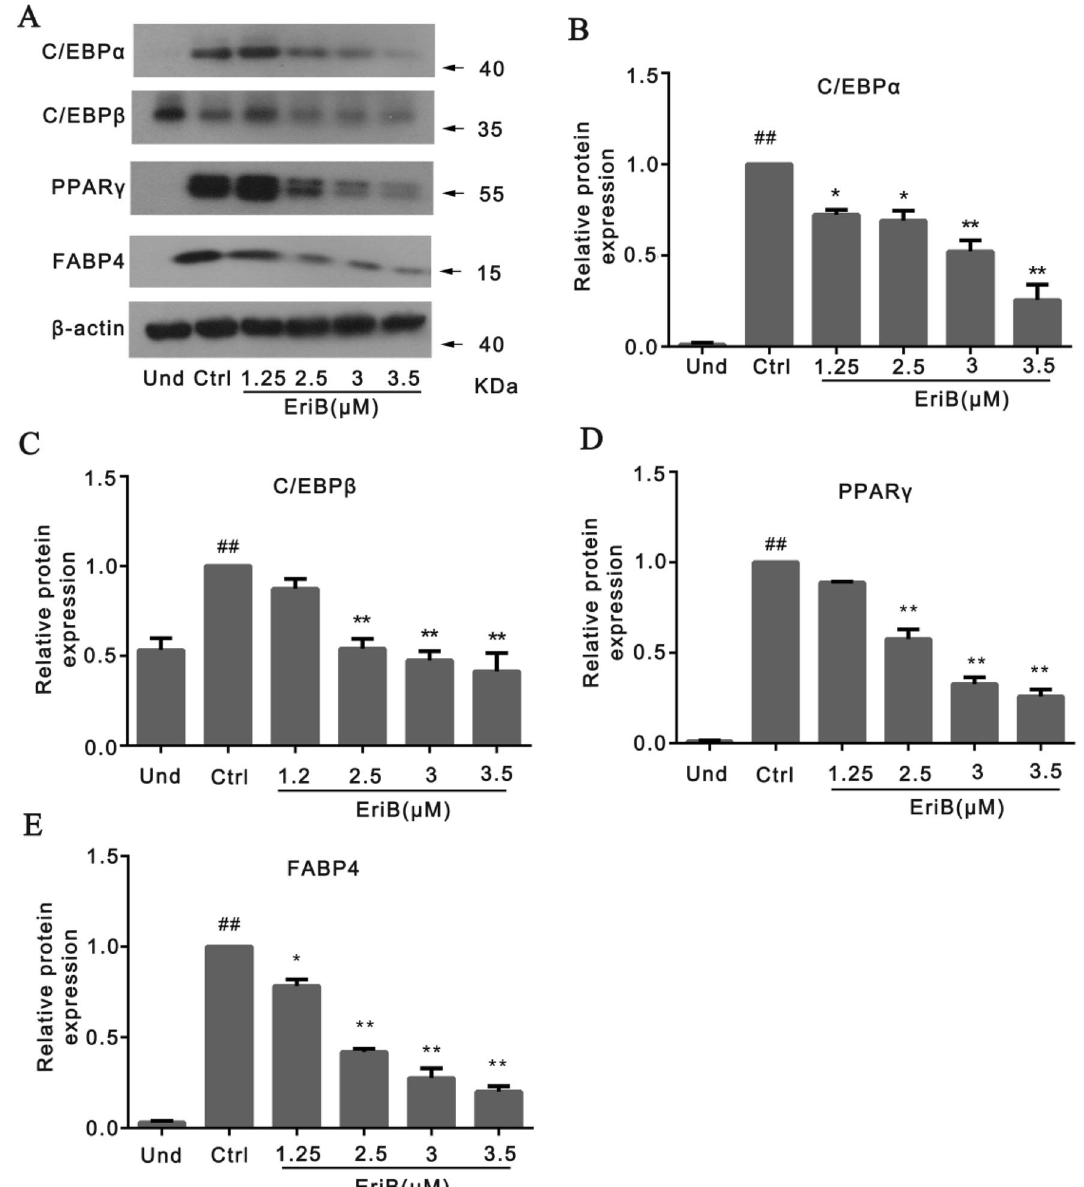
Fig. 2 Eriocalyxin B blunted the key regulators in adipocyte dif- ferentiation. a Western blotting of the cells treated with a series of doses of eriocalyxin B as indicated for C/EBPα, C/EBPβ, PPARγ and FABP4. b – e Quantified and normalized protein levels of C/EBPα, C/